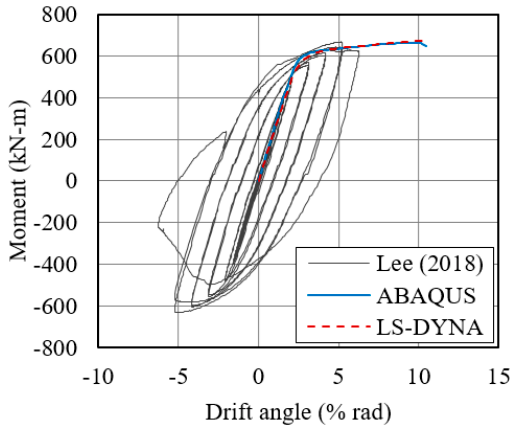
Figure 8. Moment-drift curves calculated numerically using finite element codes and obtained experimentally by Lee [16] for verification and validation.